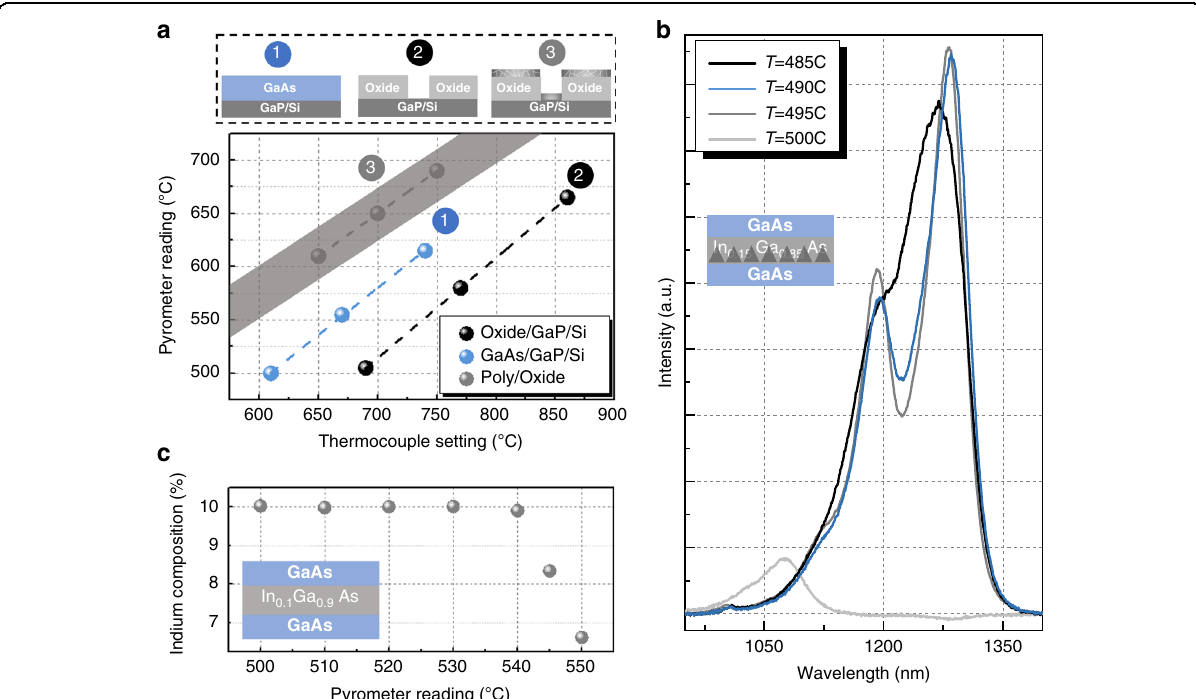
Fig. 2 Identi fi cation of the temperature offset window. a Pyrometer reading discrepancy between different surface conditions. The shaded area indicates the range of readings obtained depending on the polycrystal thickness, with the lower and the upper boundaries indicating the reading measured at the beginning and the end of MBE deposition, respectively. The points in pro fi le 3 represent pyrometer measurements obtained just before InAs QD deposition. b PL growth temperature series on native GaAs substrate. c Indium composition as a function of growth temperature. The insets of (b) and (c) illustrate the test sample structures.